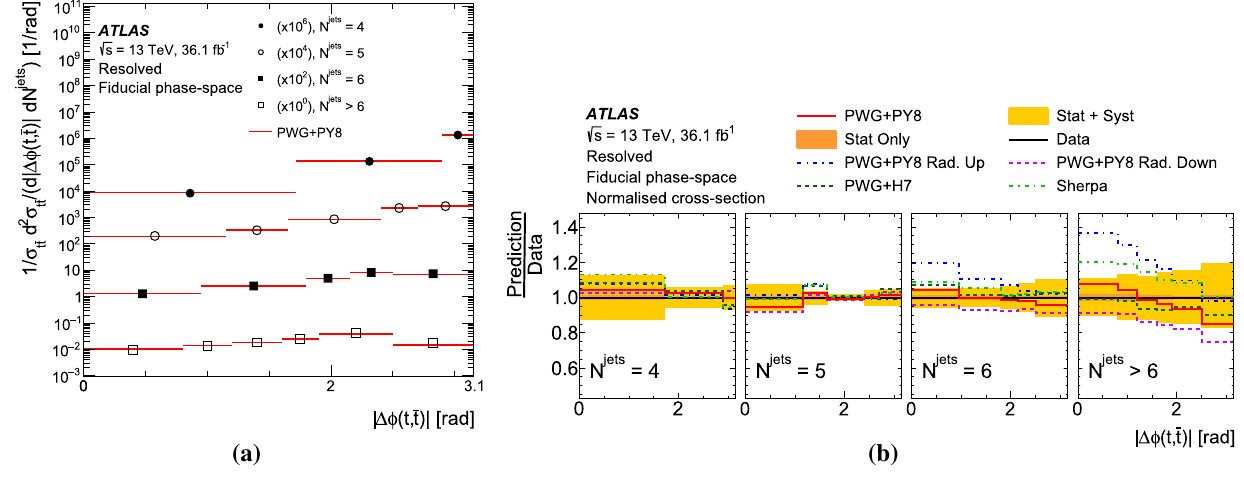
Fig. 34 a Particle-levelnormaliseddifferentialcross-sectionasafunc- (cid:7) (cid:5)(cid:7) (cid:4) (cid:7) (cid:8)φ (cid:7) in bins of the jet multiplicity in the resolved topology t , ¯ t tion of compared with the prediction obtained with the Powheg + Pythia8 MC